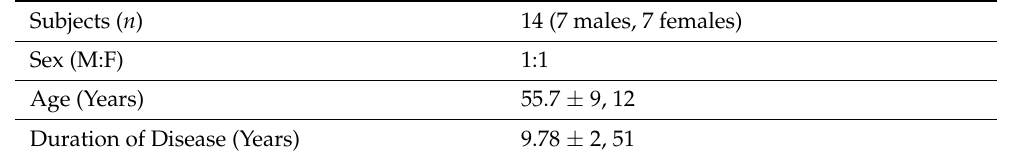
Table 1. Main demographics of the